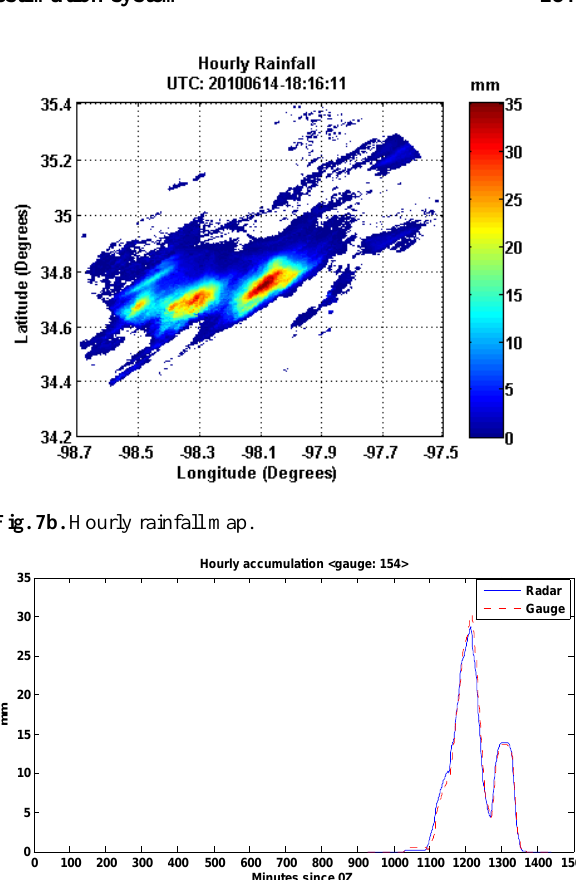
Fig. 7c. Radar and gauge hourly rainfall comparison at the location of gauge 154 for 14 June 2010